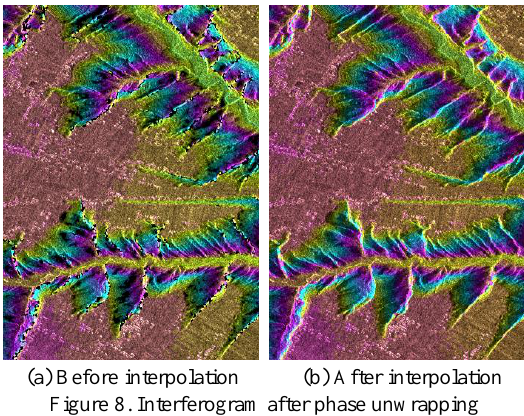
Figure 8. Interferogram after phase unwrapping